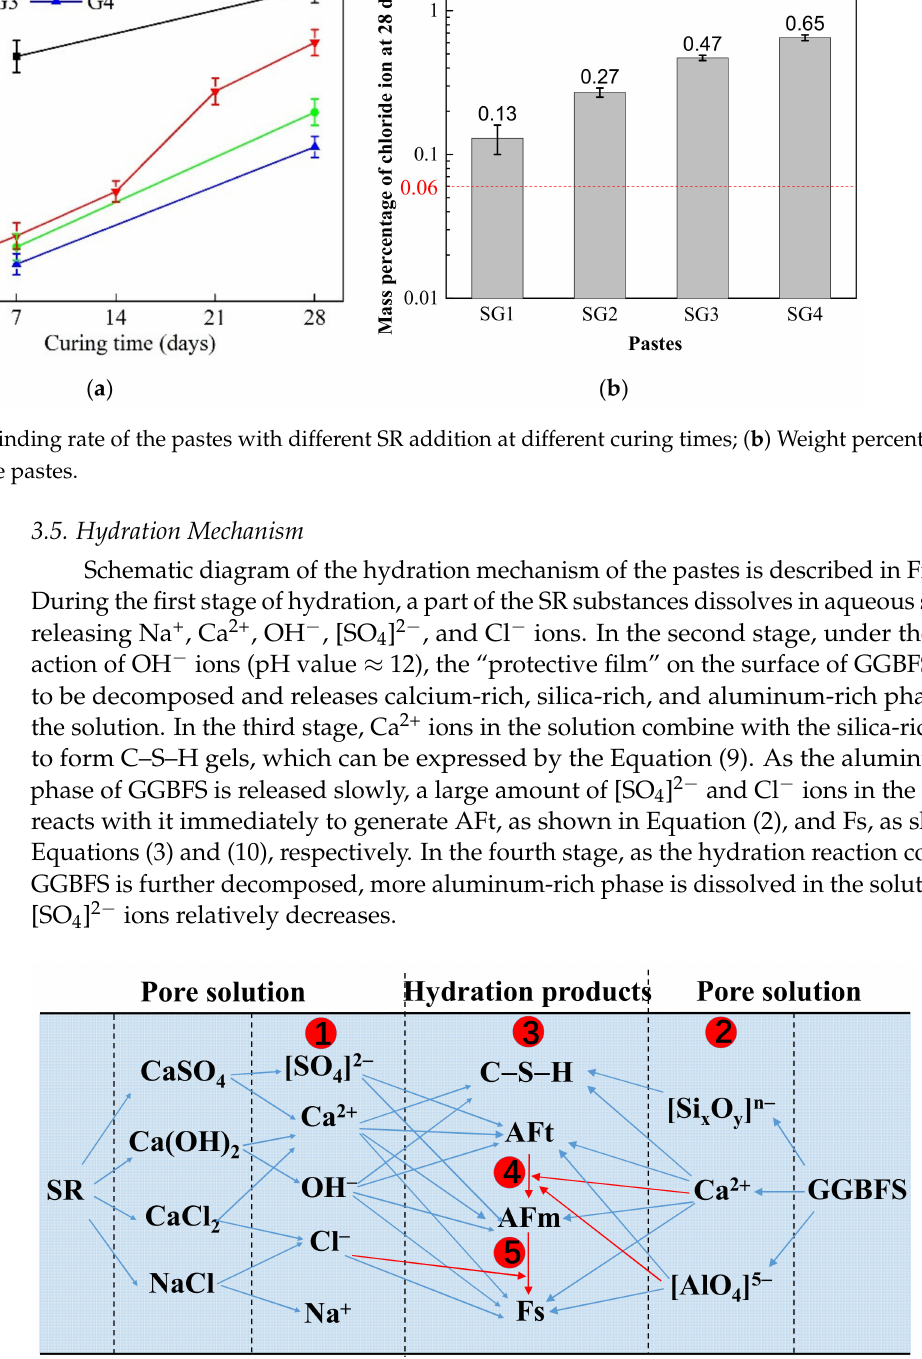
Figure 12. Schematic diagram of the hydration mechanism of SR-activated GGBFS pastes. The blue background represents the aqueous solution of the reaction; The symbols, 1 (cid:13) , 2 (cid:13) , 3 (cid:13) , 4 (cid:13) , and 5 (cid:13) , represent the first, second, third, fourth, and fifth stage of the reaction,